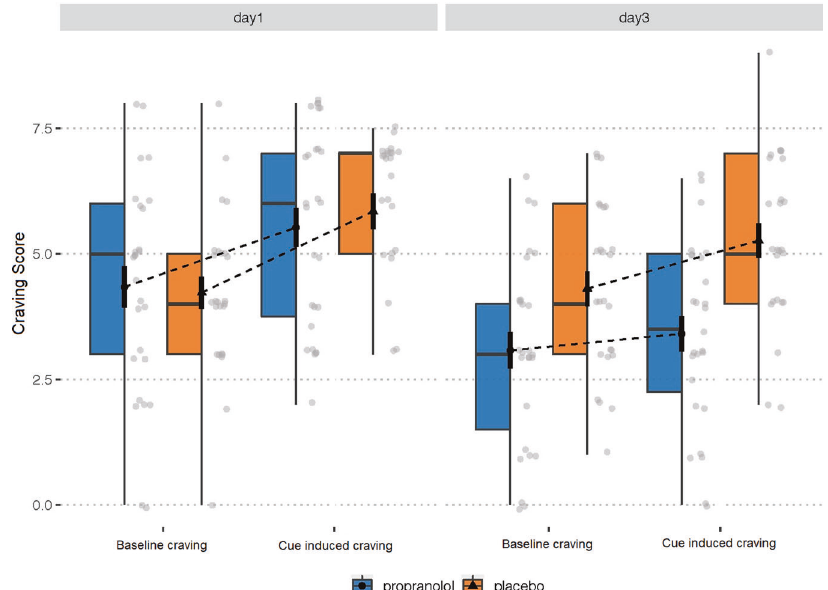
Fig. 2 Propranolol-induced disruption of reconsolidation decreases smoking craving. The ANOVA showed a signi fi cant group (propranolol, placebo) × time (day 1, day 3) interaction for craving scores. The simple-effect analysis revealed that craving scores signi fi cantly decreased from day 1 to day 3 in the propranolol group but not in the placebo group. This analysis also revealed that after the reconsolidation manipulation, the propranolol group (blue bars) exhibited a more signi fi cant decrease compared with the placebo group (orange bars). Error bars indicated the